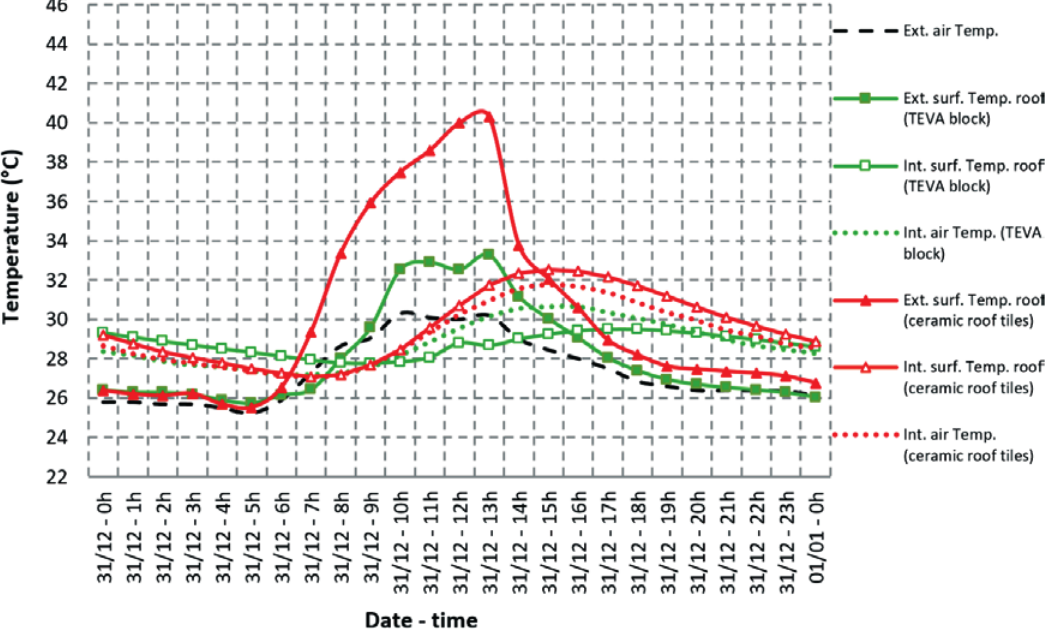
Thermal behavior of the prototype with the green roof with TEVA blocks on the slab and of the prototype with ceramic roof tiles on the slab, on the selected typical summer